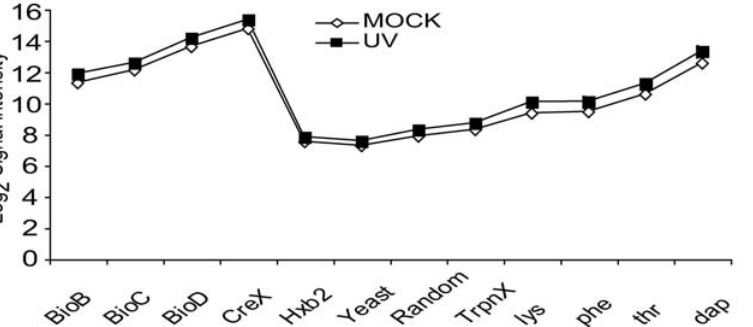
Figure 5. Reference and UV treated control probeset average intensities. Average intensity for all control probes in reference (Mock) and treated (UV irradiated) E. coli . Note the consistent difference on all spiked in genes.